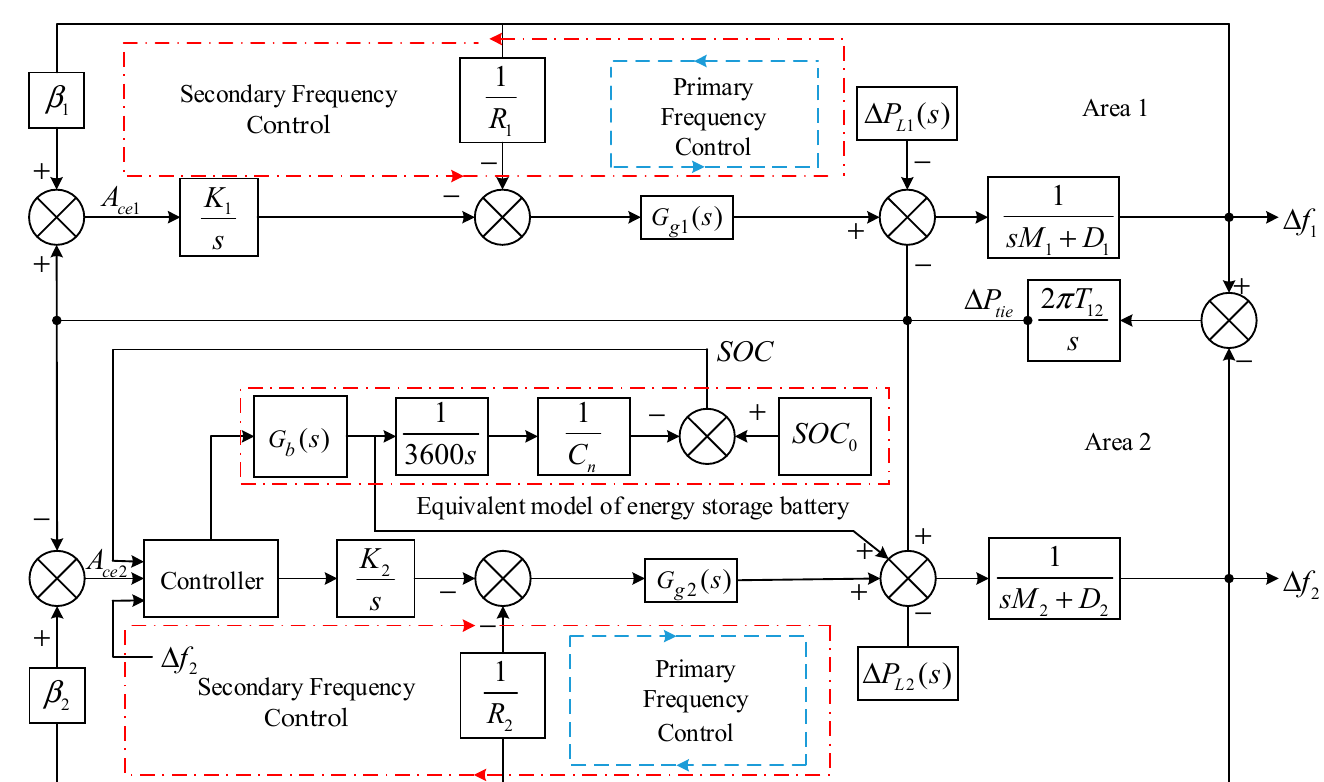
Figure 1. Frequency control model of the two-zone system with energy storage devices. In Figure 1, G g i ( s ) is the simplified model of the generator set comprising the governor model G gov ( s ) and reheat turbine model G T ( s ) in series, and i = 1, 2 represents the two regions. ∆ P Li , ∆ P ti , ∆ P ri , ∆ X gi , ∆ P tie , and ∆ f i are the load disturbance, turbine output power increment, reheater output power increment, governor position increment, tie-line power deviation, and frequency deviation, respectively. β i and R i are the power system deviation coefficient and unit adjustment coefficient, respectively. M i and D i are the regional inertia coefficient and regional damping coefficient, respectively. T 12 is the synchronization coefficient of the tie line; A cei is the regional control deviation; C n is the rated capacity of energy storage; S oc0 and S oc represent the initial SOC and real-time SOC for BESSs.